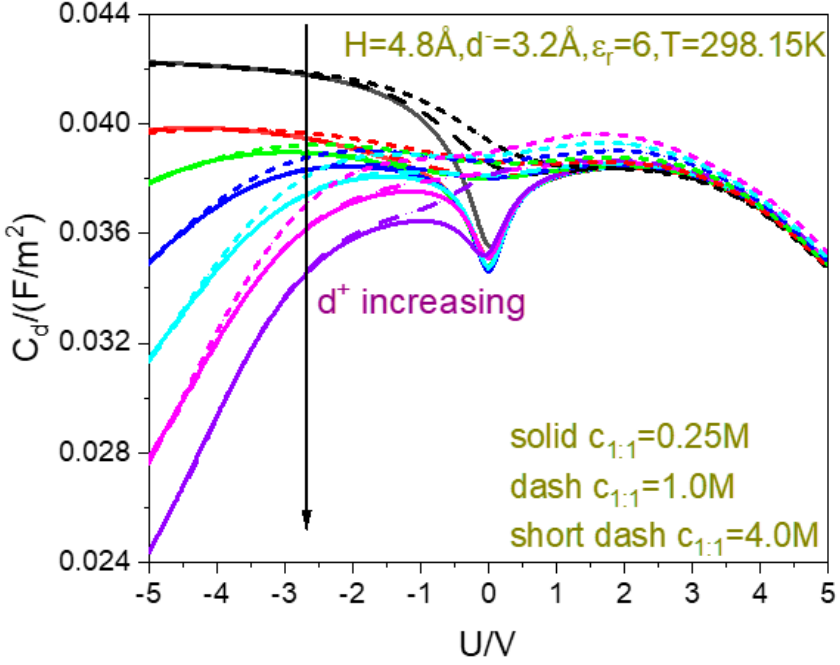
Figure 4. Correlation between the counter- and co-ion sizes and differential capacitance–voltage curves. The cation diameter in Å changes from 2, 2.4, 2.8, 3.2, 3.6, 4.0, to